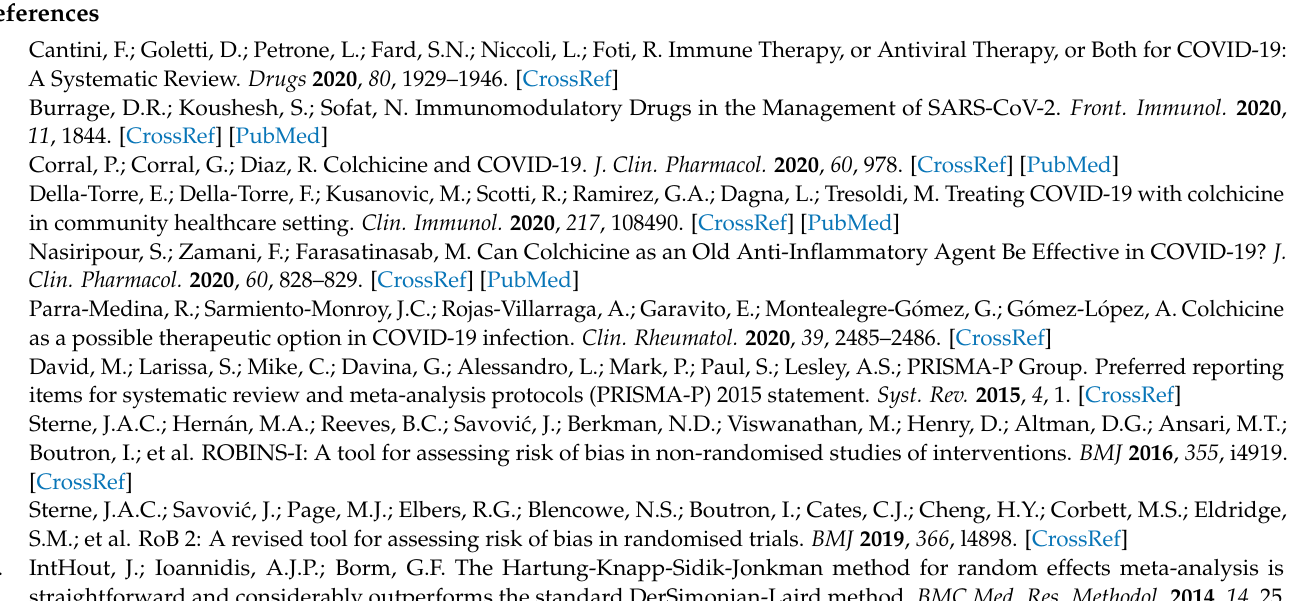
trials. Figure S2: Sensitivity analyses of the effects of colchicine vs standard of care on mortality. Table S1: Search strategy for each engine. Table S2: Ongoing randomized controlled trials. Table S3: GRADE summary of findings